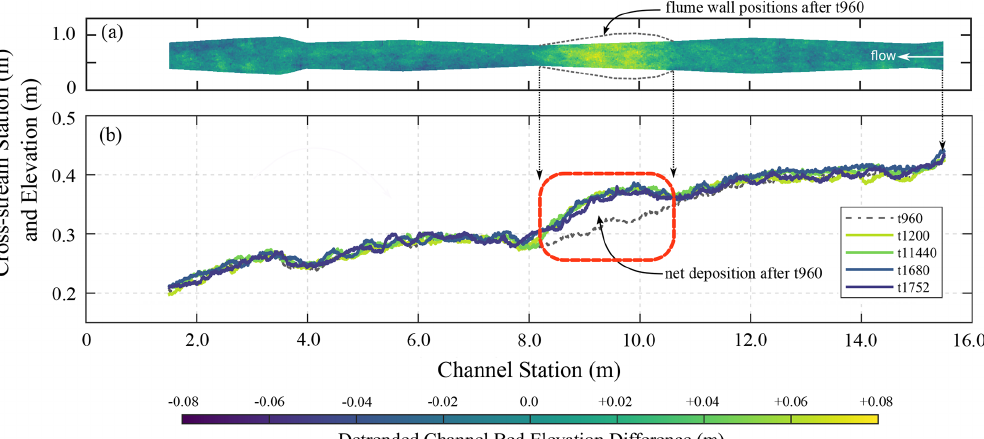
Figure 5. Bed elevation and profile changes after the width reduction was removed. (a) DEM of difference between t 960 and t 1200min. The width profile for t 960min used to show elevation differences because it was narrower within the central part of the flume compared to t 1200min. Width profile following t 960min is shown with the light gray lines. (b) Trended mean channel bed profiles for t 960, t 1200, t 1440, t 1680, and t 1752min. The dashed red box lines up with region where the width reduction was removed following t 960min. Profiles calculated as width-averaged conditions with a resolution of